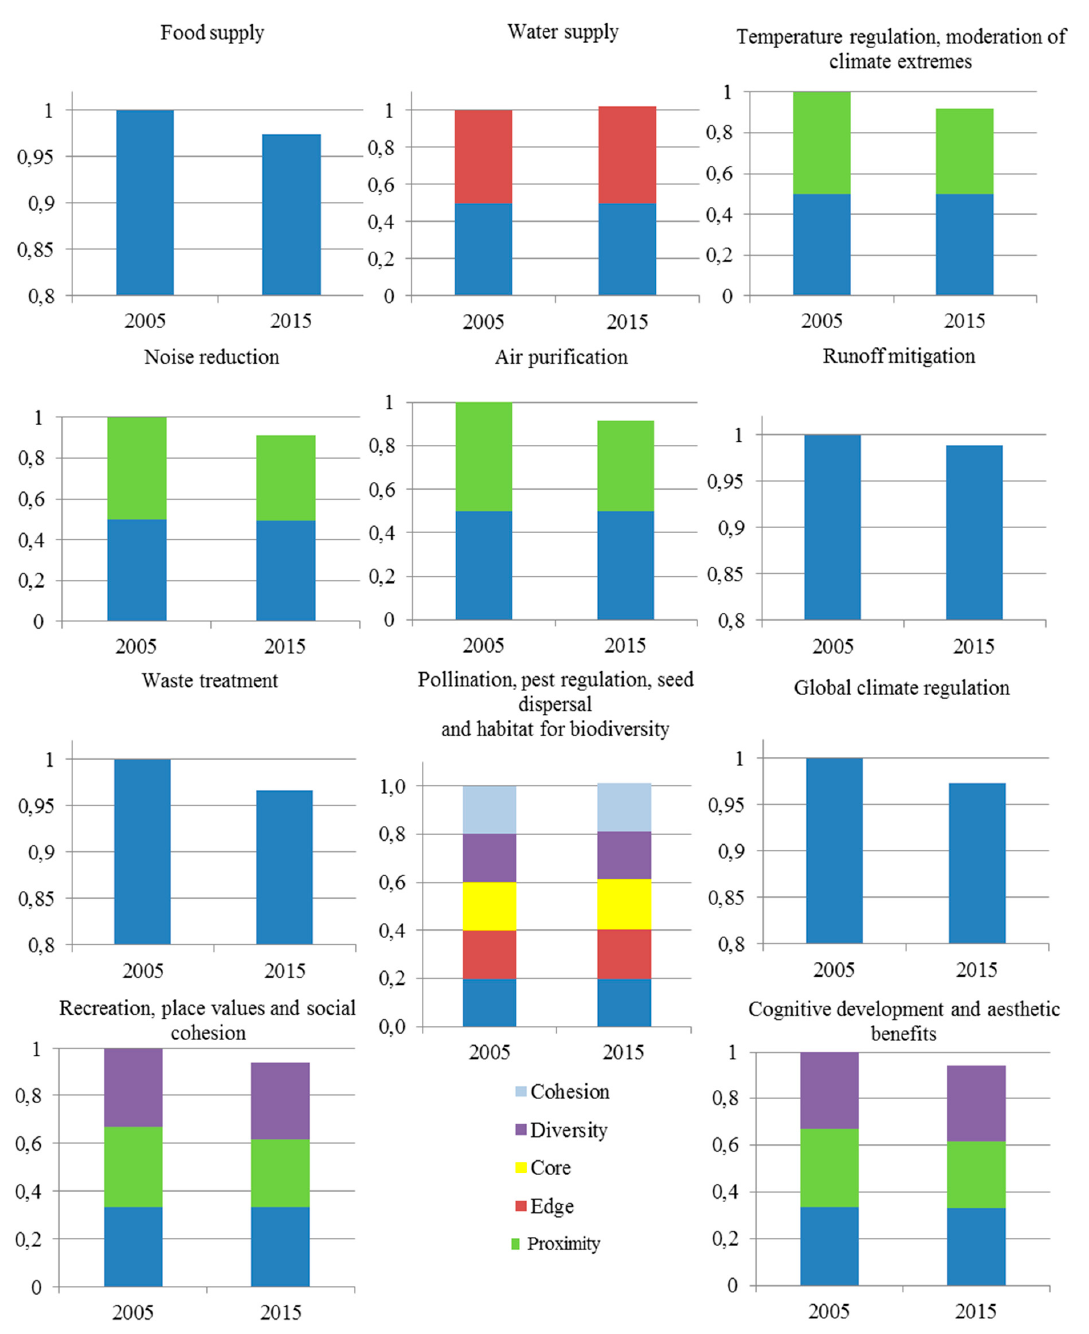
Figure 4. Ecosystem service bundle changes and share of landscape metric influence in Stockholm County between 2005 and 2015 (adapted from Haas and Ban [21]).